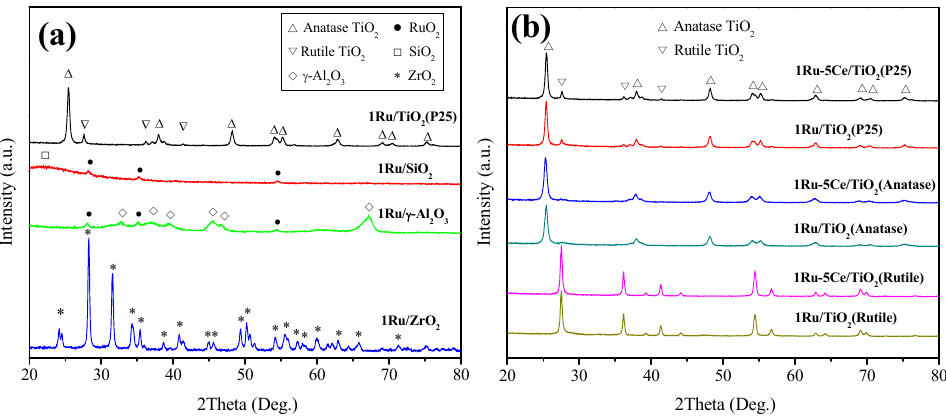
Figure 6. XRD patterns of ( a ) 1Ru/TiO 2 (P25), 1Ru/ZrO 2 , 1Ru/ γ‐ Al 2 O 3 , and 1Ru/SiO 2 , and ( b ) 1Ru/TiO 2 and 1Ru ‐ 5Ce/TiO 2 .